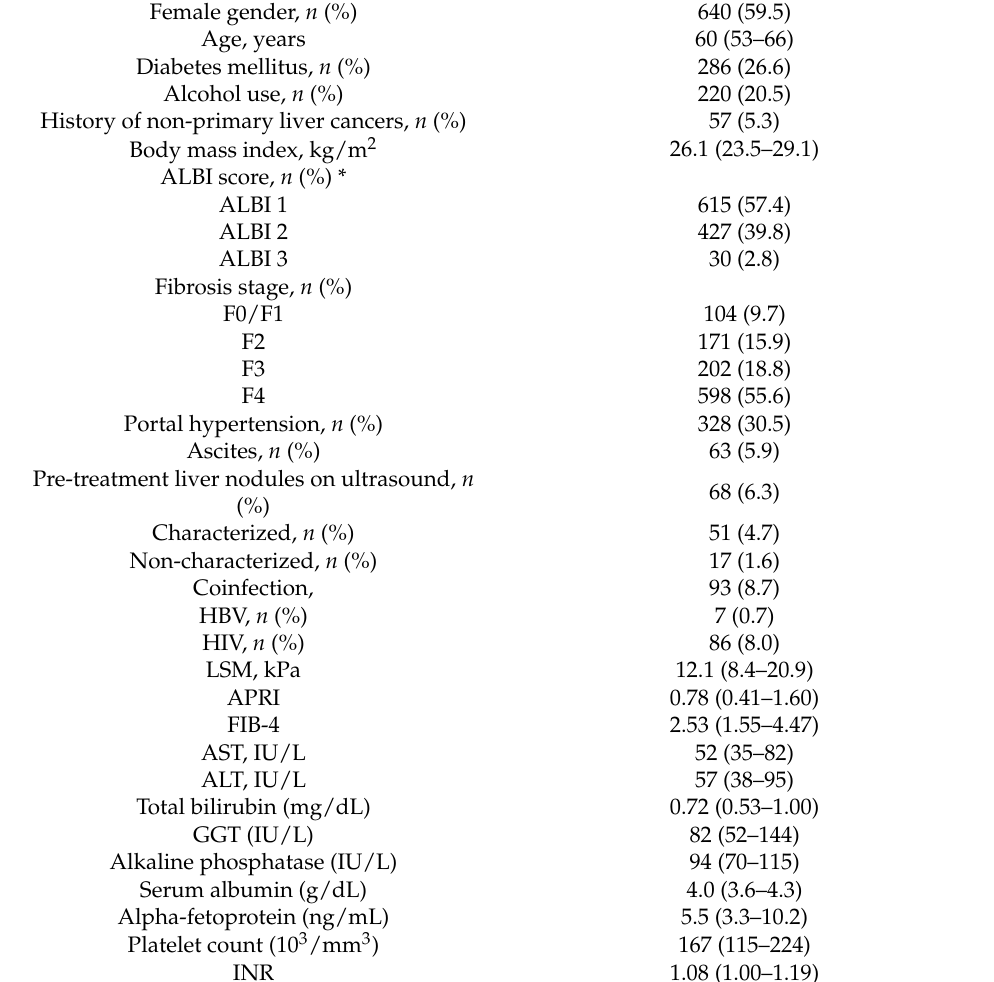
Table 1. Baseline demographic, clinical and laboratorial characteristics of patients (N =